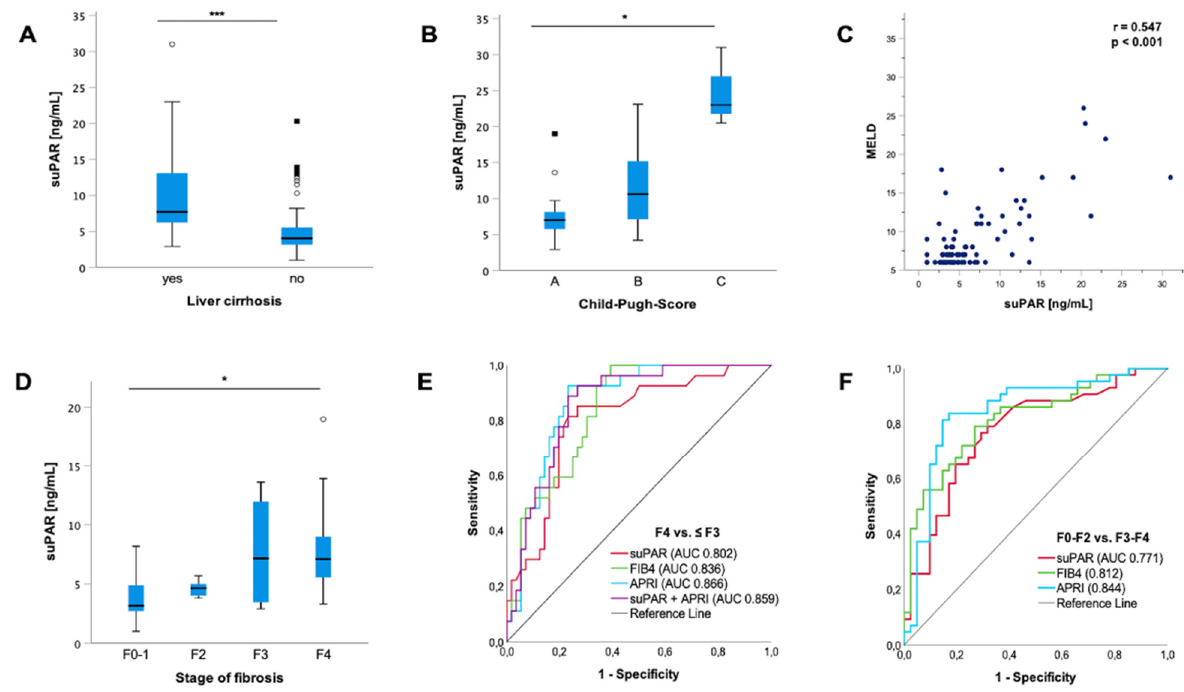
Figure 2. suPAR is associated with the presence of liver cirrhosis. Soluble urokinase-type plasminogen activator receptor (suPAR) is elevated in patients with liver cirrhosis ( p < 0.001) ( A ). suPAR is linked to an increasing Child–Pugh score (CHILD) in patients with liver cirrhosis ( p = 0.019; A–C: p = 0.047; B–C: p = 0.046; A–B : n .s.) ( B ). In line with this, according to Spearman rank correlation, suPAR increases with increasing model of end-stage liver disease (MELD) score ( p > 0.001; r = 0.547) ( C ). Subdivision of groups with different fibrosis stages revealed an elevation in suPAR levels ( p = 0.017; F1 vs. F4 p = 0.001; F1–F2 : n. s.; F1–F3 : n. s.;F2–F3 : n. s.) ( D ). suPAR revealed a high accuracy for the discrimination of the presence of liver cirrhosis (area under the curve (AUC) 0.802 (95%CI: 0.702–0.902), which is comparable to previously validated noninvasive fibrosis markers such as the fibrosis-4 (FIB4) index (AUC 0.836; 95%CI (0.752–0.920) and aspartate transaminase-to-platelets ratio index (APRI) score (AUC 0.866; 95%CI (0.789–0.944). The combination of suPAR and APRI score further improved the diagnostic power for the discrimination of the presence of liver cirrhosis (AUC 0.859 (95%CI (0.780–0.938)) ( E ). Subdivision of our cohort into patients with no to mild fibrosis (F0–F2) and patients with a higher degree of fibrosis (F3–F4) demonstrated a lower AUC of 0.771 (95%CI (0.669–0.874) for suPAR. However, the AUC was still comparable to the FIB4 index (AUC 0.812; 95%CI (0.720–0.905) and APRI score (AUC 0.844; 95%CI (0.754–0.935) ( F ). Box plots are displayed, where the bold line indicates the median per group and the edges of the box are the first and third quartiles. The horizontal lines show minimum and maximum values of calculated nonoutlier values. The dots represent calculated outliners. Soluble urokinase-type plasminogen activator receptor (suPAR). Child–Pugh Score (CHILD). Model of end-stage liver disease (MELD). Fibrosis-4 (FIB4) index. Aspartate transaminase-to-platelets ratio index (APRI). (* p < 0.05; *** p < 0.001).